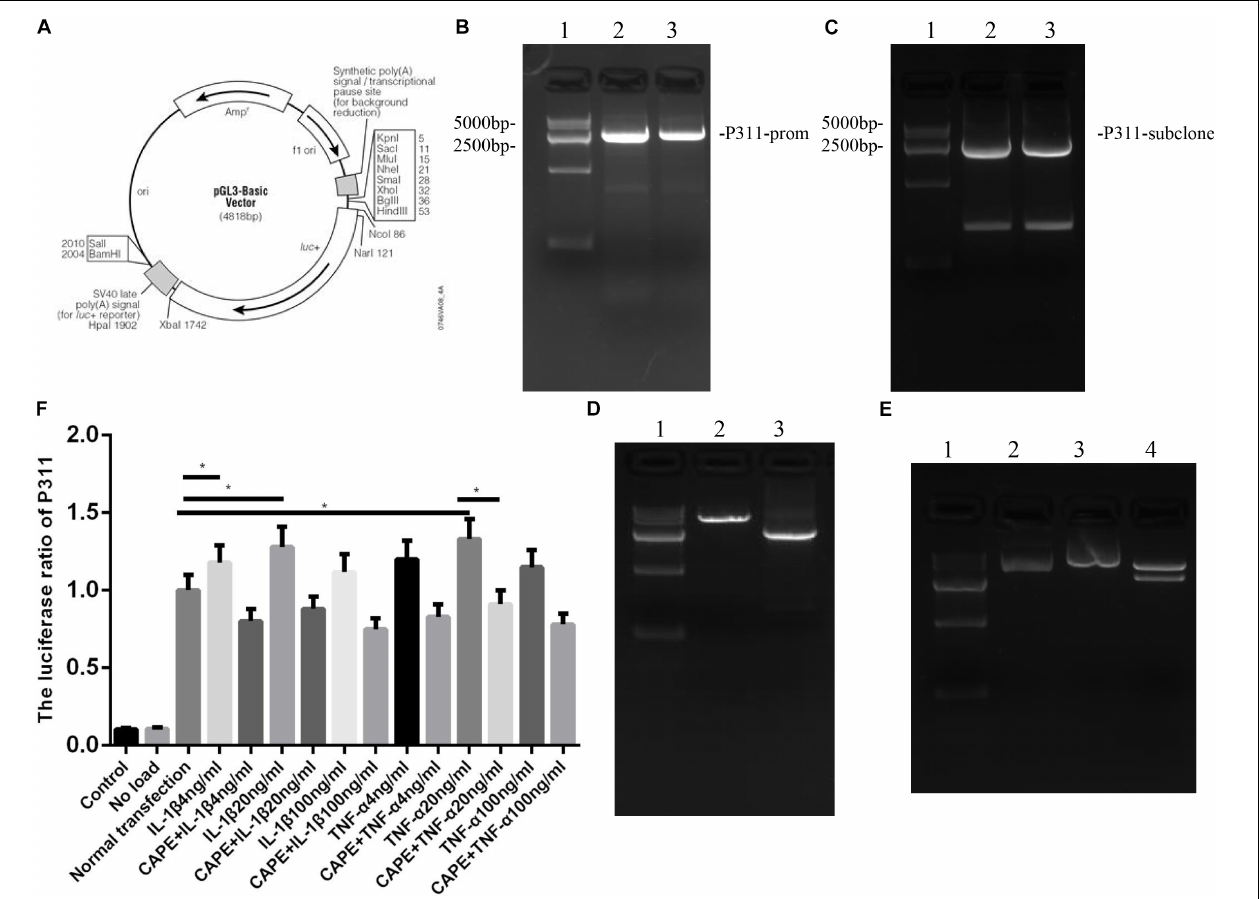
FIGURE 5 | Influences exerted by NF- κ B on the activity of the P311 promoter in vascular endothelial cells and analysis of binding sites. Mean ± standard deviation (SD) denote the experimental results; * indicates P < 0.05. (A) P311 promoter expression plasmid. (B) P311 electropherogram. (C) P311 subclone band. (D) Luciferase activity report under CAPE intervention. (E) Luciferase activity report. (F) The Iuciferase ratio of